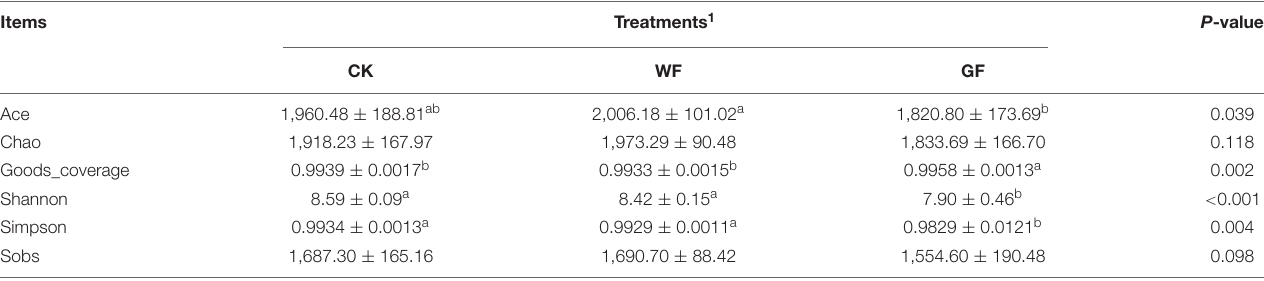
TABLE 4 | Effects of dietary whole and ground flaxseed supplementation on α -diversity indexes of rumen bacteria. Items